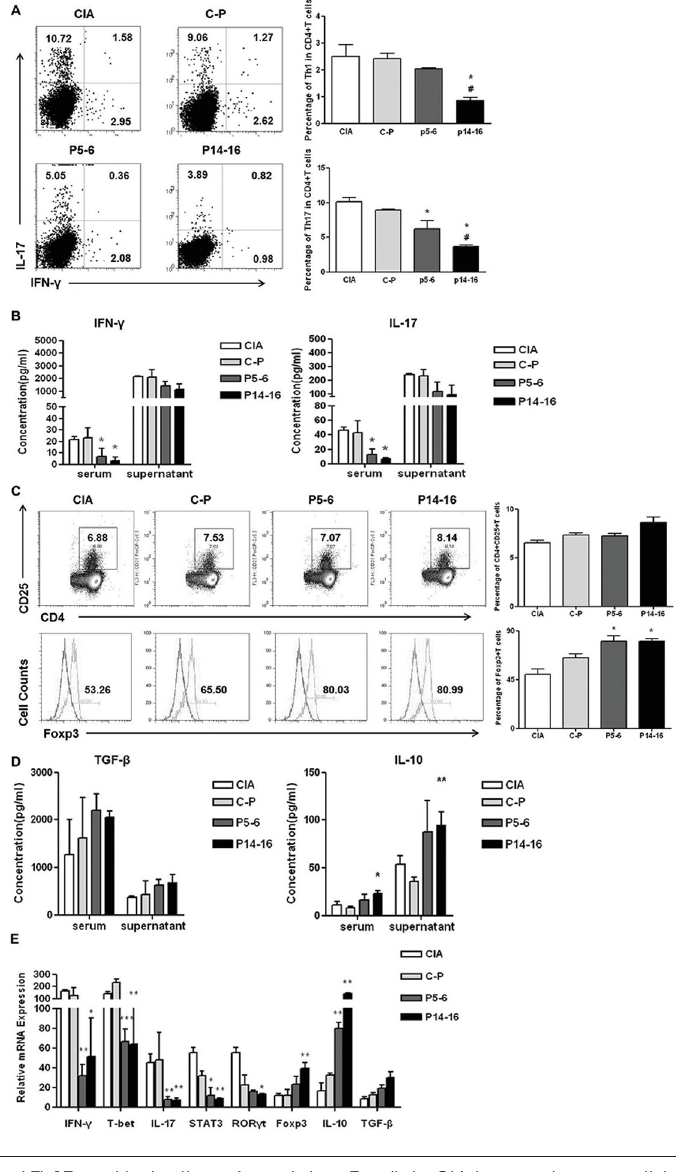
Figure 4. Downregulation of Th1 and Th17 and induction of regulatory T cells in CIA by ergotope peptide treatment. (A) Splenic mononu- clear cells were isolated on d 14 post first immunization from untreated (CIA) or C-P, P5–6 or P14–16 treated mice with CIA and stimulated in vitro with CII (20 μ g/mL) for 48 h and analyzed for CD4 and intracellular cytokine expression by flow cytometry. Dot plots (left) show representative double staining for IL-17A and IFN- γ in gated CD4 + T cells. Percentages of CD4 + IFN- γ + (Th1) and CD4 + IL-17A + (Th17) are shown on the right. Values are the mean ± SD of eight mice per group and pooled from three independent experiments. *: P < 0.05 versus C-P group; #: P < 0.05 versus P5–6 group. (B) Cytokine production was assessed by ELISA in sera and in supernatants by splenic mononuclear cells with CII stimulation (20 μ g/mL) for 48 h. Values are the mean ± SD of eight mice per group. (C) Regulatory T cells were analyzed in the splenocytes from indicated groups by flow cytometry. Percentages of CD4 + CD25 + T cells are shown in the rep- resentative dot plots (upper panel). Histograms show the expression of FOXP3 + cells (dark gray lines) in gated CD4 + CD25 + cells from splenocytes, while light gray lines indicate antibody isotype controls. Data are representative of eight mice per group. Statistical analysis is displayed on the right. Values are the mean ± SD. *: P < 0.05 versus C-P group. (D) Treg-secreted cytokines TGF- β and IL-10 were mea- sured by ELISA in sera and in supernatants by splenic mononuclear cells with CII stimulation (20 μ g/mL) for 48 h. Values are the mean ± SD of eight mice per group. (E) The expressions of Th cell related mRNA, IFN- g , T-bet , IL-17 , STAT3 , ROR g t , FOXP3 , IL-10 and TGF- b in splenic mononuclear cells were detected by real-time qPCR at CII (20 μ g/mL) stimulation for 24 h. *: P < 0.05; **: P < 0.01; ***: P < 0.001 versus C-P